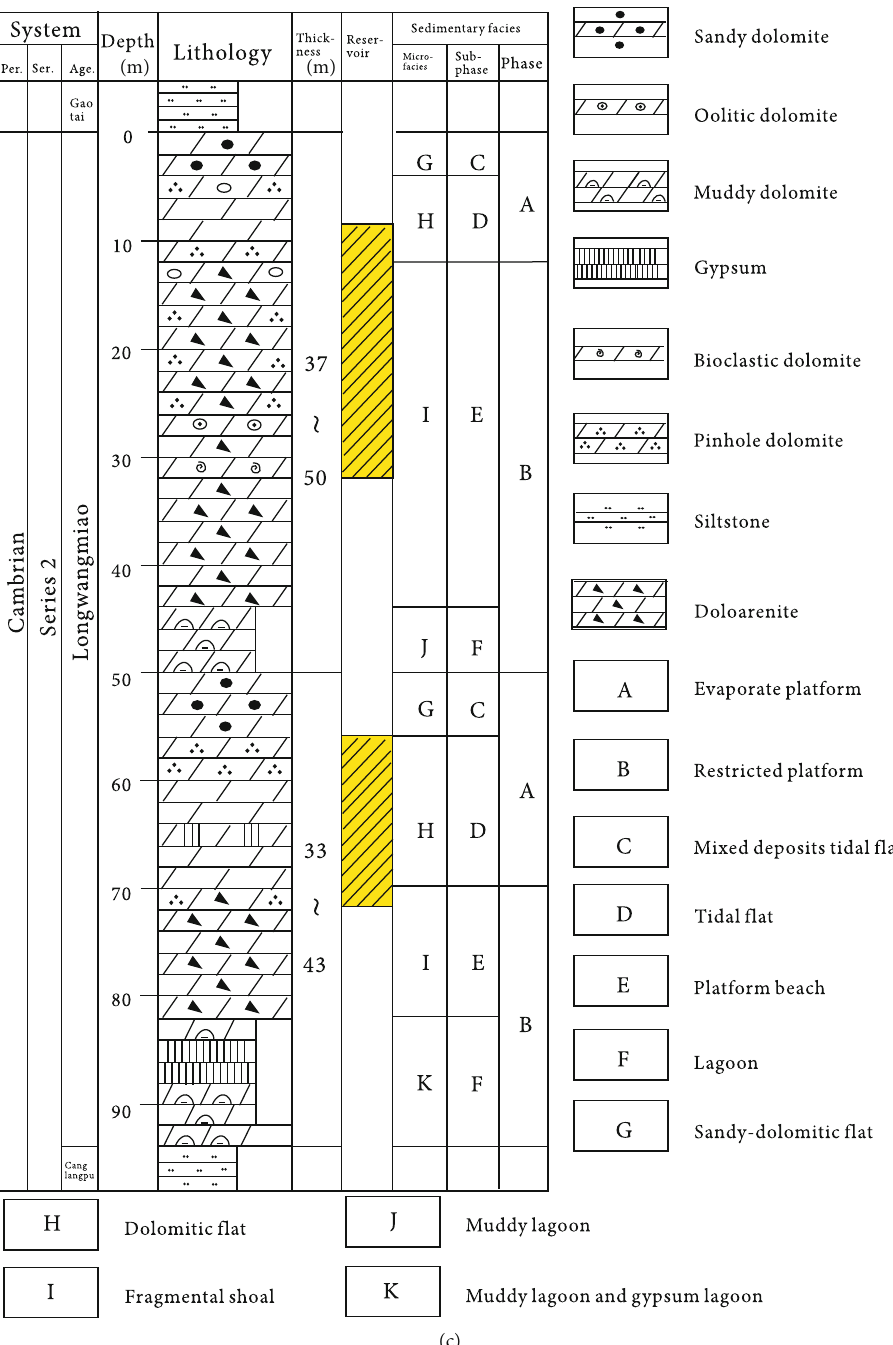
Figure 1: (a) The location and sedimentary facies of the research area. (b) Basement structure map and sample well location of the Longwangmiao Formation. (c) Stratigraphy of the Longwangmiao